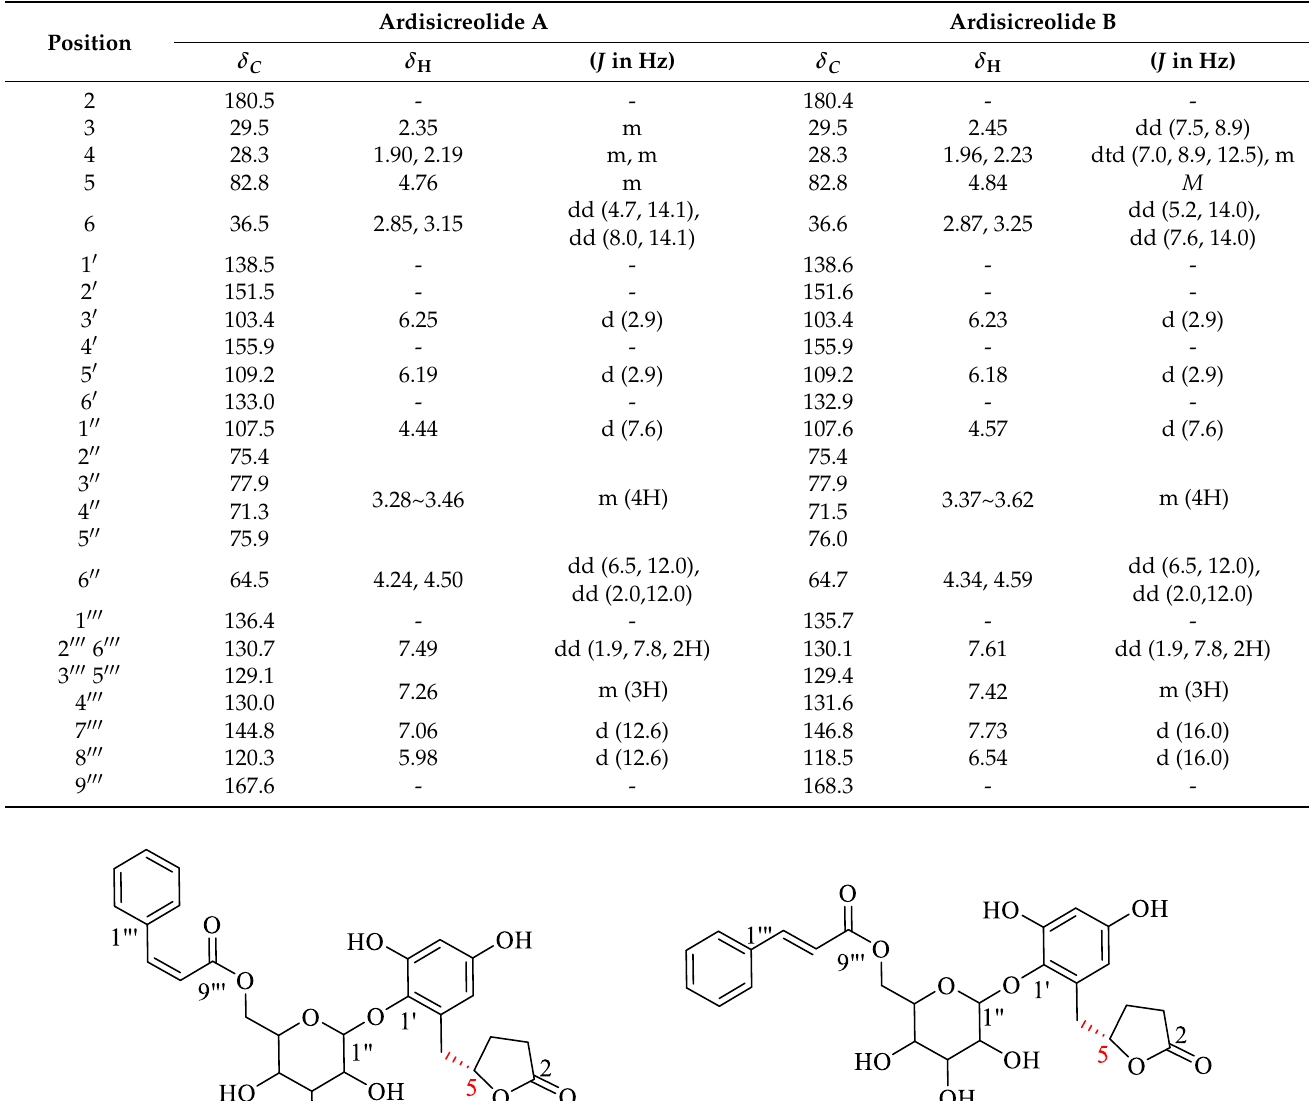
Table 1. The 1 H and 13 C-NMR data of compounds 1 – 2 in CD 3 OD ( δ in ppm).